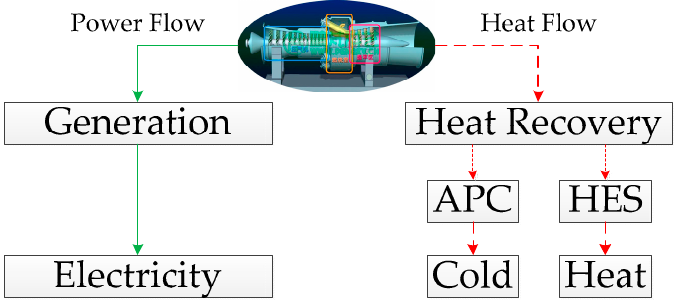
Figure 2. The structure of micro-gas turbine’s (MT’s) combined cooling-heating-power (CCHP) mode. APC: absorption chiller; HES: heat-exchanging system.